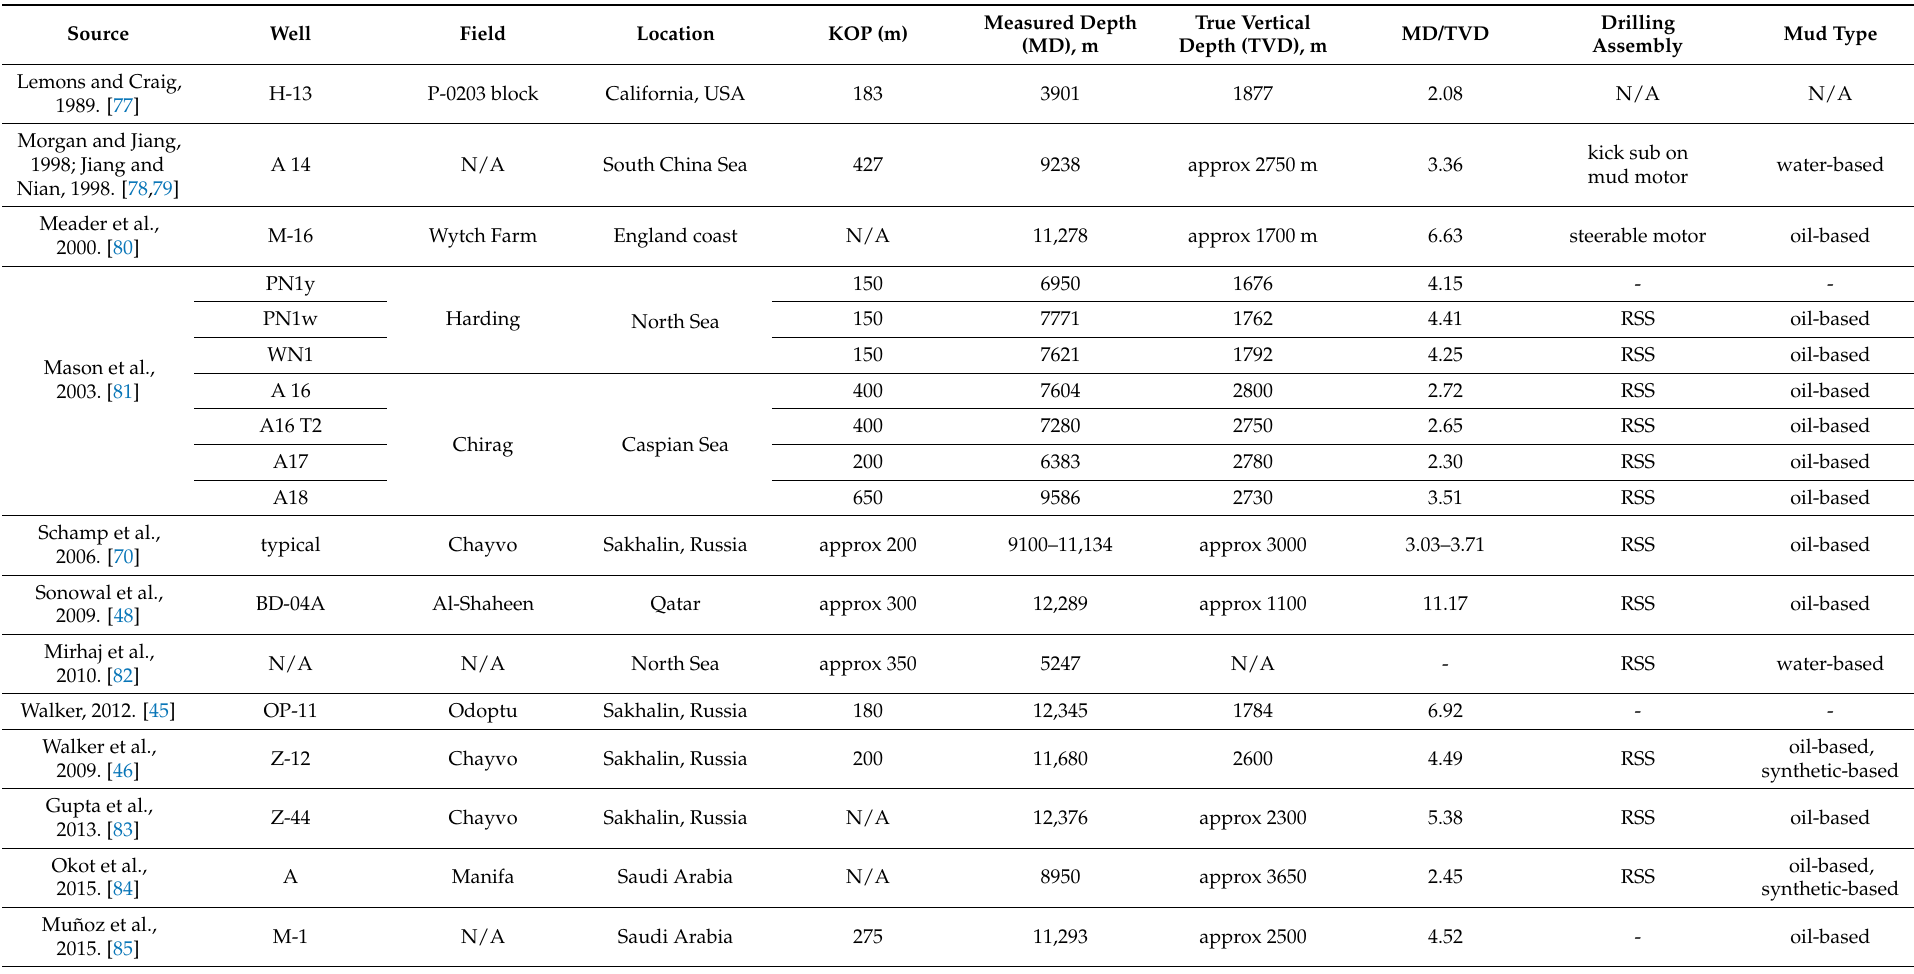
Table 2. The main information about the analyzed extended-reach